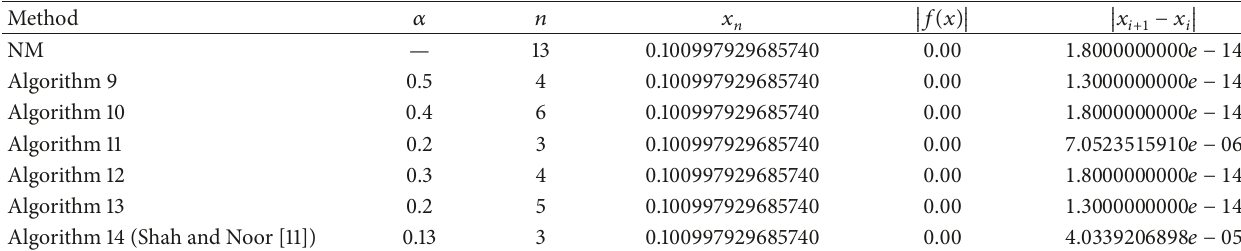
Table 1: Numerical results for Example 16 when 𝑝(𝑥) = 𝑒 −𝛼𝑥 .